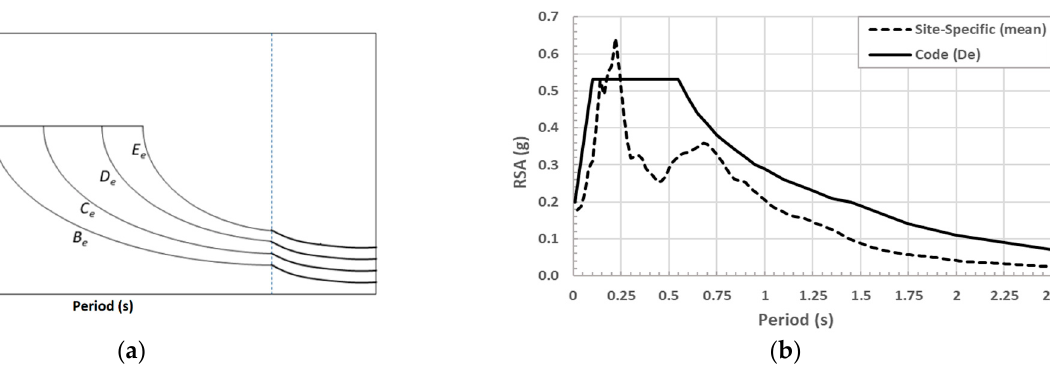
Figure 1. Comparison of the site-specific mean response spectrum and the code response spectrum. ( a ) Elastic code response spectrum for different ground types. ( b ) Site-specific (mean) and the code acceleration response